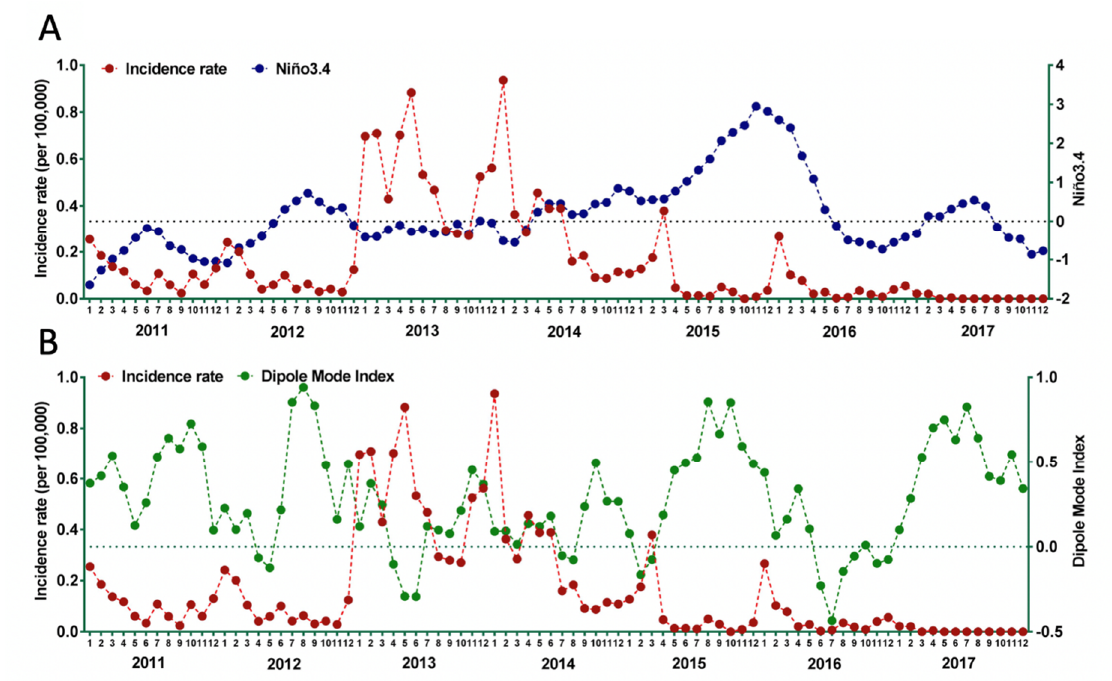
Figure 3. Temporal trend of Niño3.4 and chikungunya incidence rate ( A ) and DMI and chikungunya incidence rate ( B ) in Indonesia, 2005–2017.